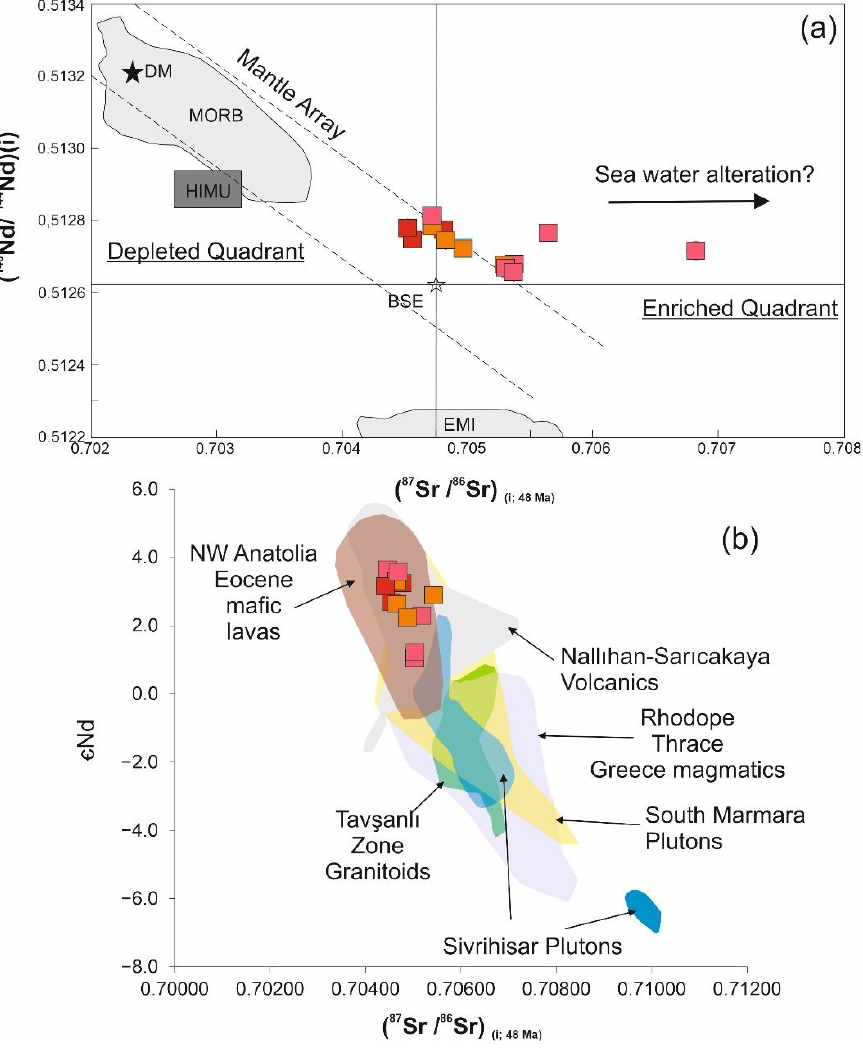
Figure 11. ( a ) Initial 87 Sr/ 86 Sr and 143 Nd/ 144 Nd compositions of three different volcanic units from the Sarıcakaya–Nallıhan Basin. Compositions of MORB and Mantle Array from [49]; EMI (enriched mantle type I), BSE (Bulk silicate earth), HIMU, CHUR (Chondritic Uniform Reservoir) Sr and -Nd reference lines after [50]. ( b ) Comparison of studied lava flows with the different reservoirs from the Balkanatolia Magmatic Realm. NW Anatolia Eocene mafic lavas data from [3,7] ; Nallıhan– Sarıcakaya data from [25,38]; Rhodope – Thrace – Greece magmatics from [4]; and Tavşanlı Zone gran- itoids from [51,52].